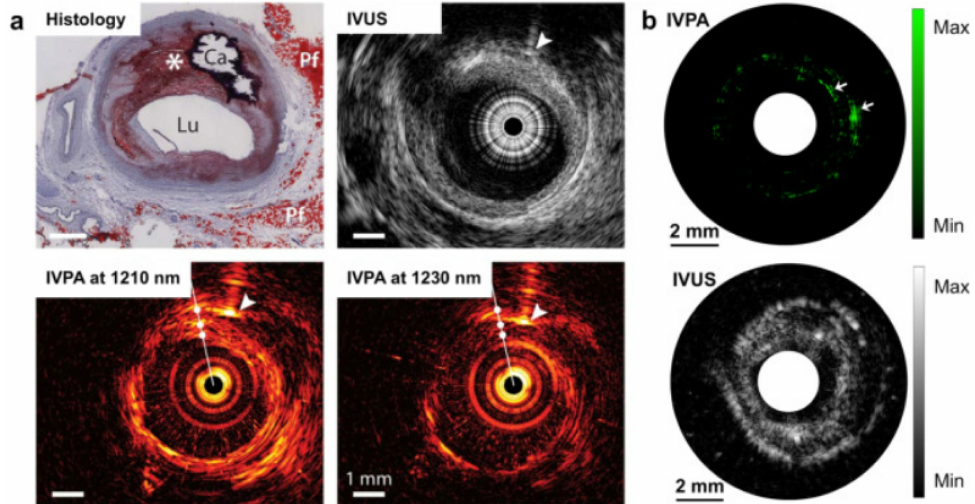
Figure 6. PA image of human artery in which dotted circle denotes the lipid-rich plaque [89]. ( a ) Intervascular photoacoustic (IVPA) and intervascular ultrasound (IVUA) image of an advanced atherosclerotic plaque in human (optical window 1.2 µ m); ( b ) IVPA and IVUS imaging of excised human femoral artery (optical window 1.2 µ